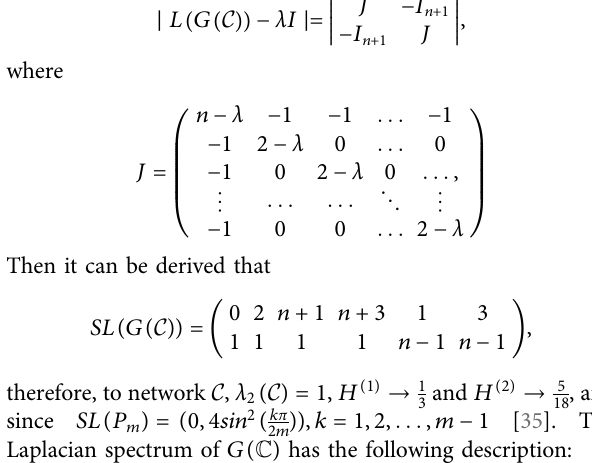
FIGURE 3 | An example of G ( C ) : ( S n × P 2 ) ◦ P m , n (cid:1) 5, m (cid:1)